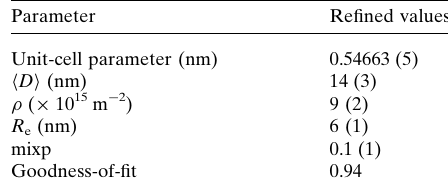
Table 3 The main results of the best refined